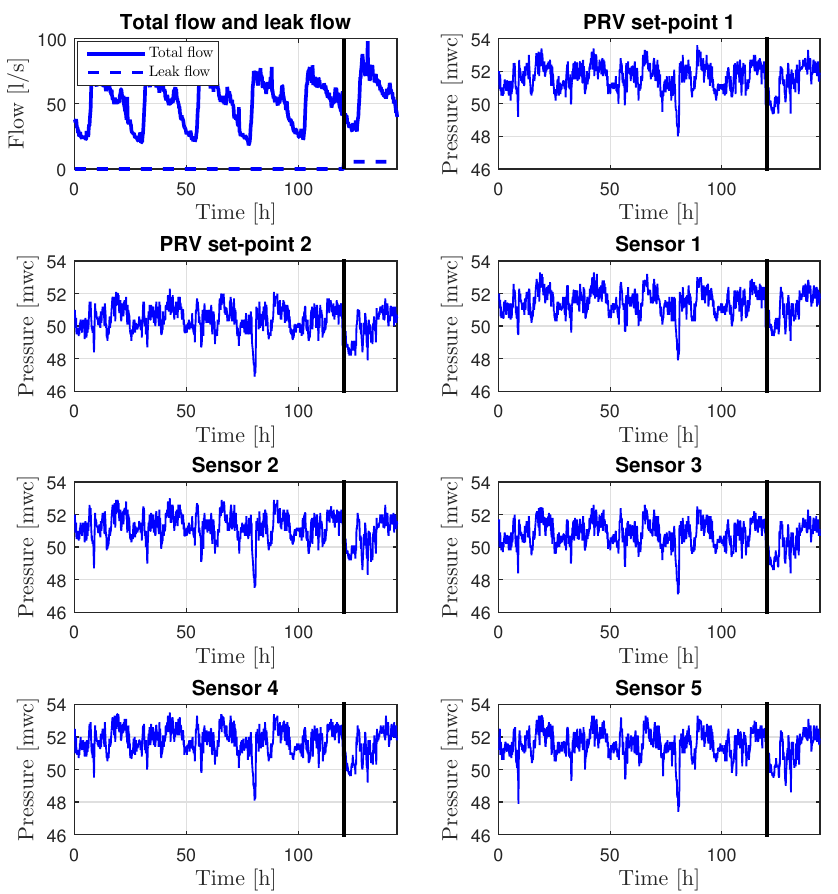
Figure 9. Nova Icària measurements under nominal conditions (before vertical line) and faulty conditions (after vertical